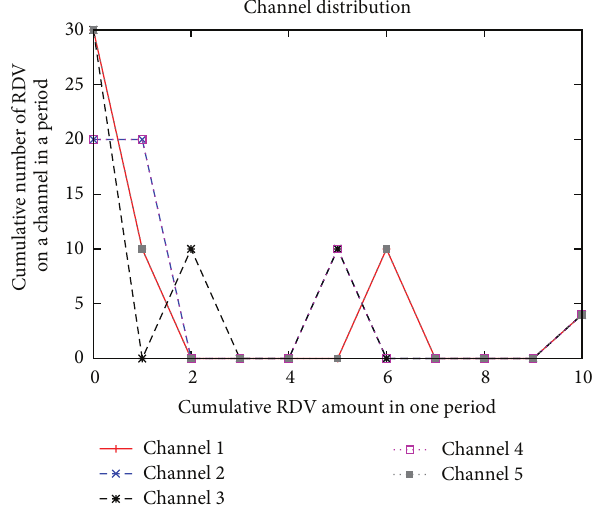
1 map, and finally information with different sequences ( 𝑆 1 and 𝑆 0 ).